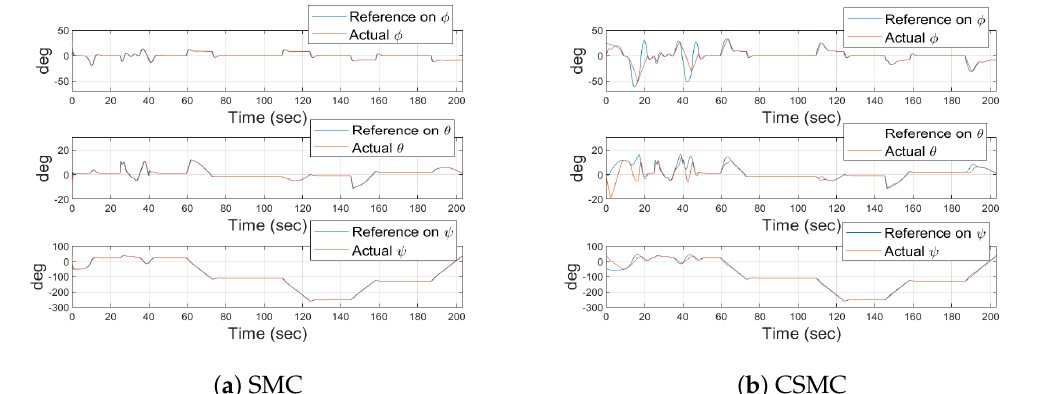
Figure 7. Time histories of Euler